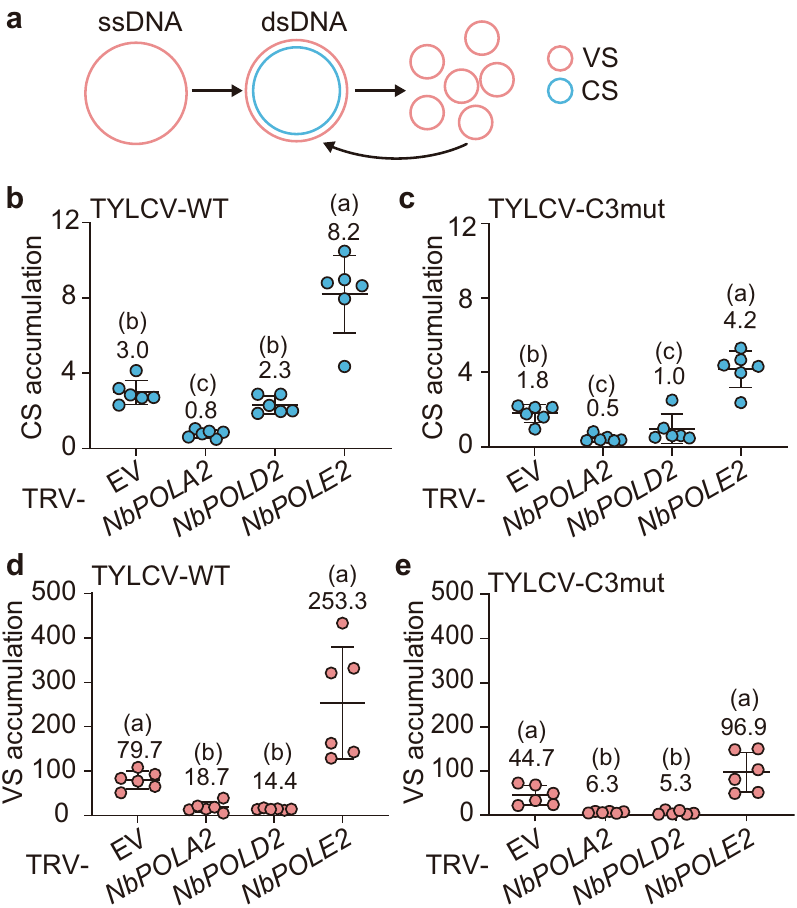
Fig. 3 Effect of silencing POLA2 , POLD2 , or POLE2 on the accumulation of viral and complementary DNA strands. a Schematic representation of the viral DNA forms during the infection. VS: viral strand; CS: complementary strand; ssDNA: single-stranded DNA; dsDNA: double-stranded DNA. b , c , d , e Accumulation of complementary strand (CS) ( b , c ) and viral strand (VS) ( d , e ) during local TYLCV infections in POLA2 -silenced (TRV-NbPOLA2), POLD2 - silenced (TRV-NbPOLD2), POLE2 -silenced (TRV-NbPOLE2), or empty vector control (EV) N. benthamiana plants, measured by qPCR at 3 days post inoculation. Data are the mean of six independent biological replicates; error bars represent SD. The 25S ribosomal DNA interspacer ( ITS ) was used as a reference gene; values are presented relative to ITS . TYLCV-WT: wild-type TYLCV; TYLCV-C3mut: C3 null TYLCV mutant. Mean values are shown. Letters indicate a statistically signi fi cant difference according to one-way ANOVA-Welch (in b : degrees of freedom df = 3, F value = 50.98; in d : degrees of freedom df = 3, F value = 18.42; in e : degrees of freedom df = 3, F value = 17.70) followed by Games – Howell ’ s multiple comparison test ( P < 0.05), or according to one-way ANOVA (in c : degrees of freedom df = 3, F value = 32.27) followed by Tukey ’ s multiple comparison test ( P < 0.05). The original data from all experiments and replicates can be found in the Source data fi